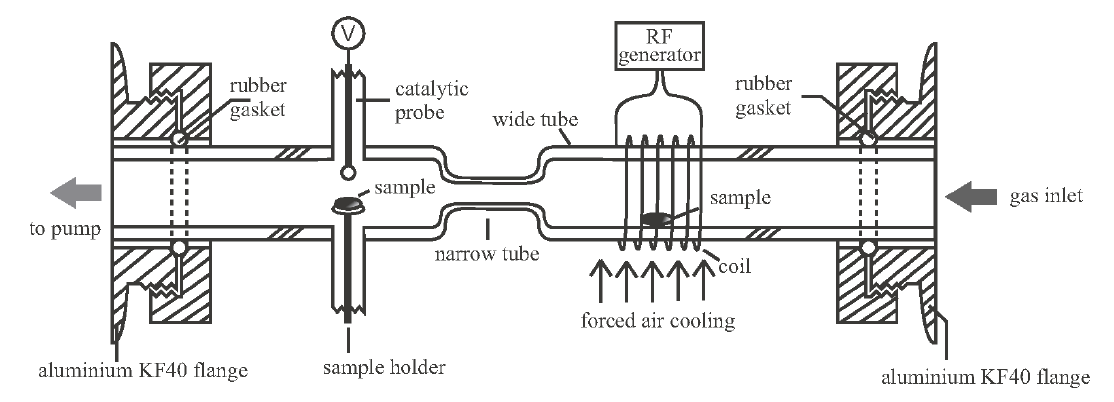
Figure 1 : Shematic of the experimental setup. Not to